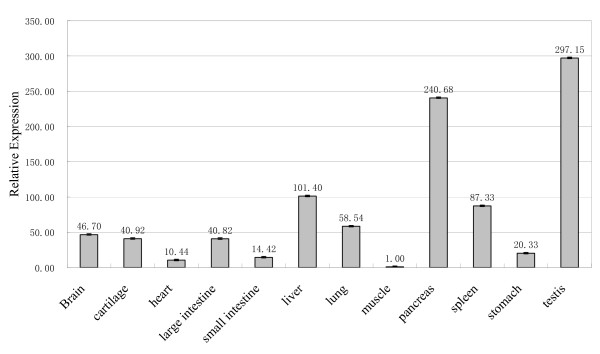
The relative expression levels of SCML1 in different tissues. A 1–2 year old male rhesus monkey was sampled and tested using real time quantitative PCR. The pancreas and testis showed the highest expression of SCML1. The numbers above the columns are the relative levels of expression.